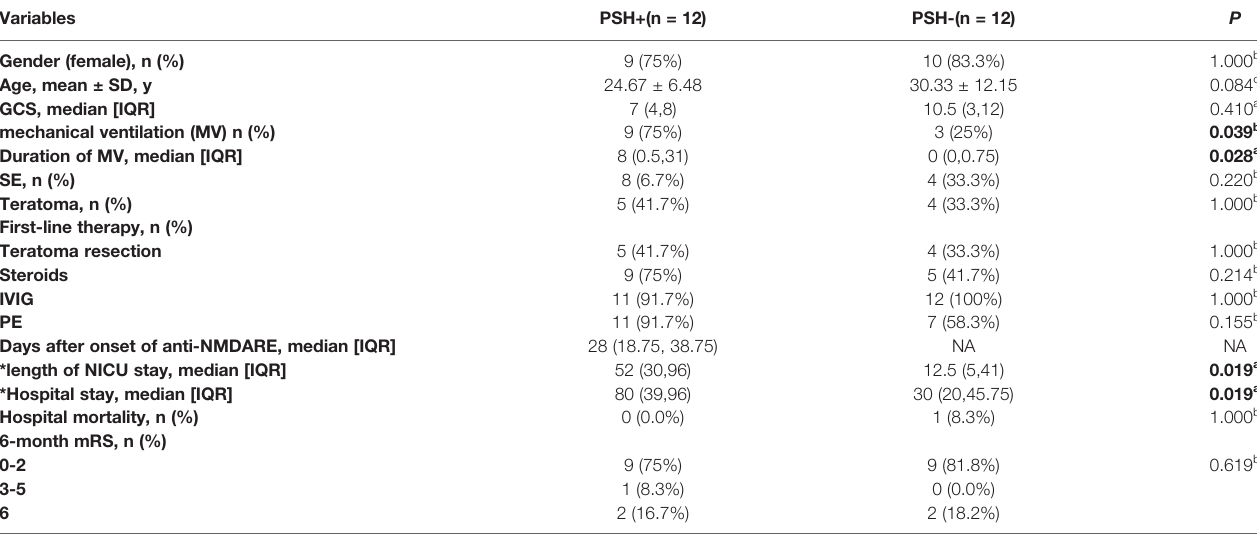
TABLE 1 | Baseline characteristics of the two